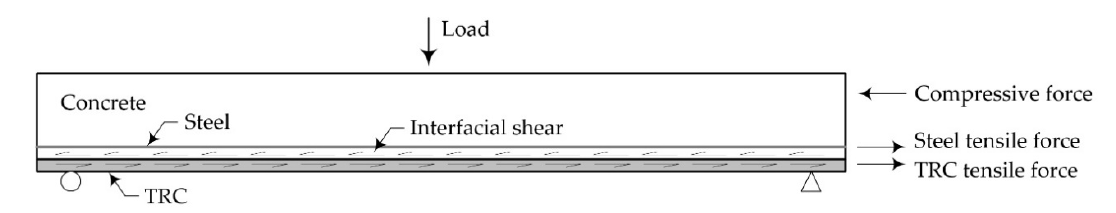
Figure 13. Load transfer mechanism of a RC flexural member strengthened with TRC system.